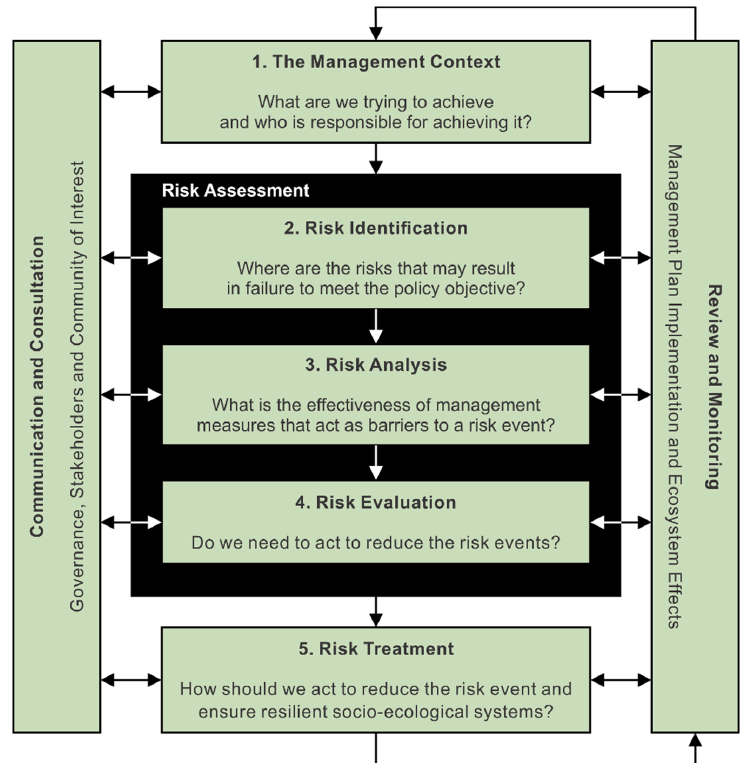
Figure 2. International Organization for Standardization (ISO) 31000 Risk Management Framework for the management of forest ‐ ecosystem risk. Modified from